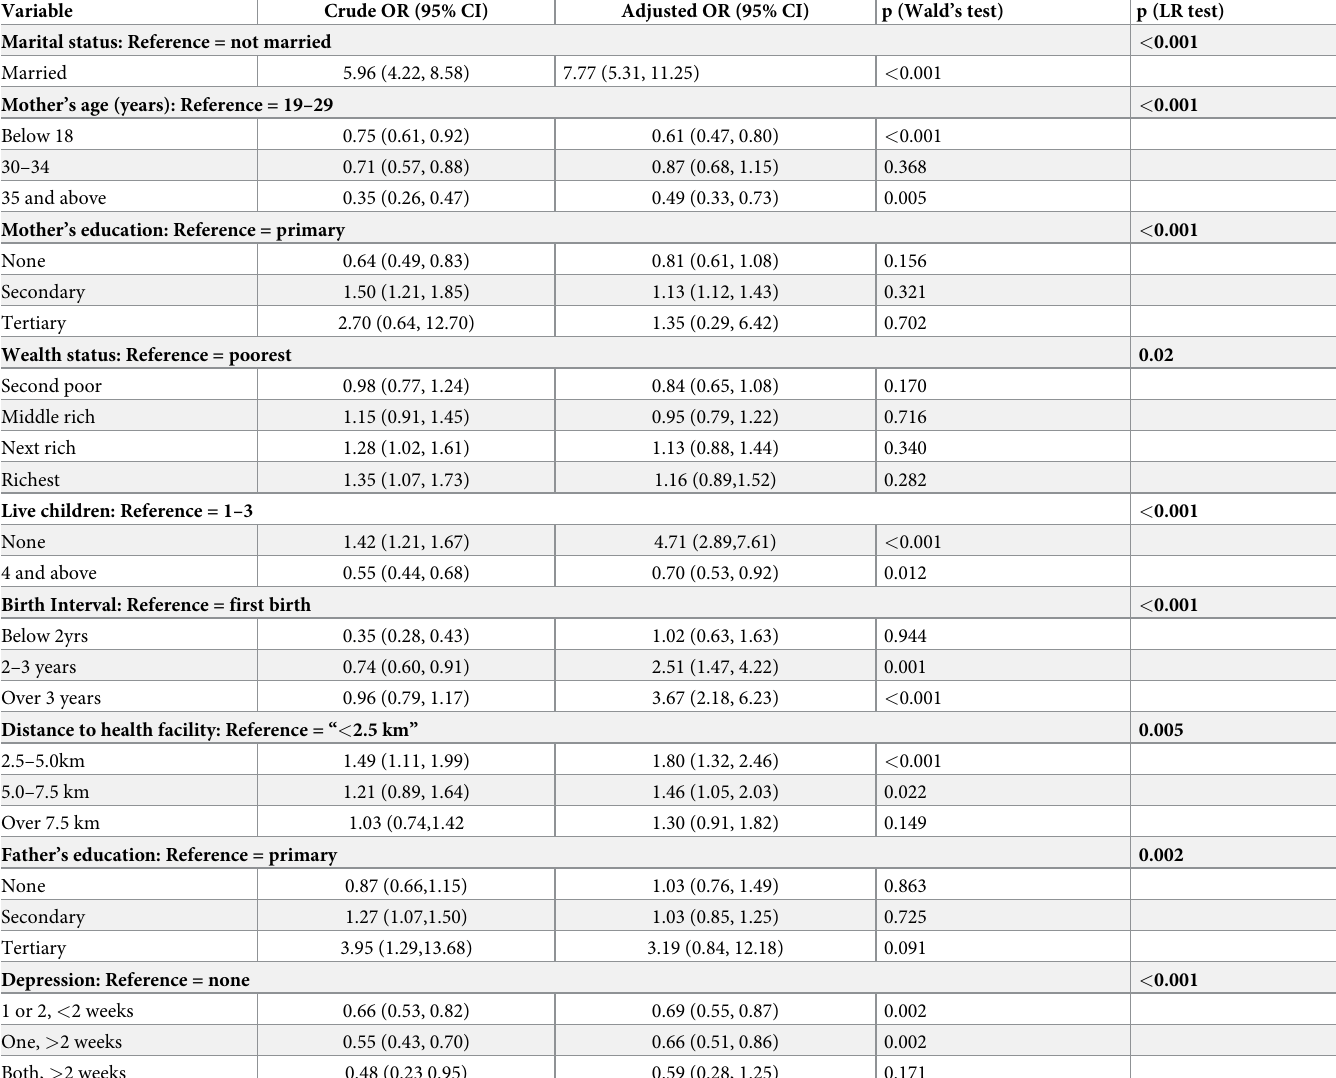
Table 3. Factors associated with pregnancy preparation, among women in Mchinji,